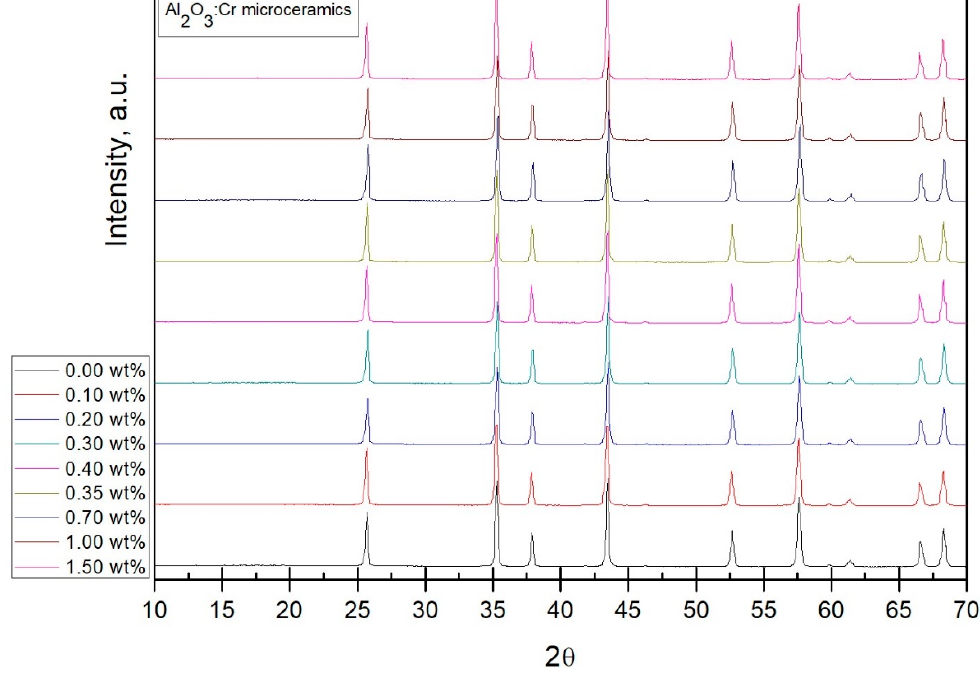
Figure 1. XRD results for all 9 samples with varying chromium concentrations.